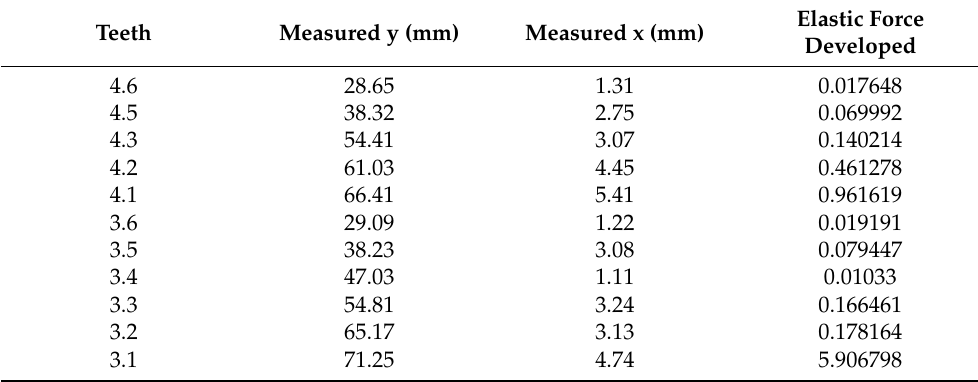
Table 8. The x and y coordinate values for the lower